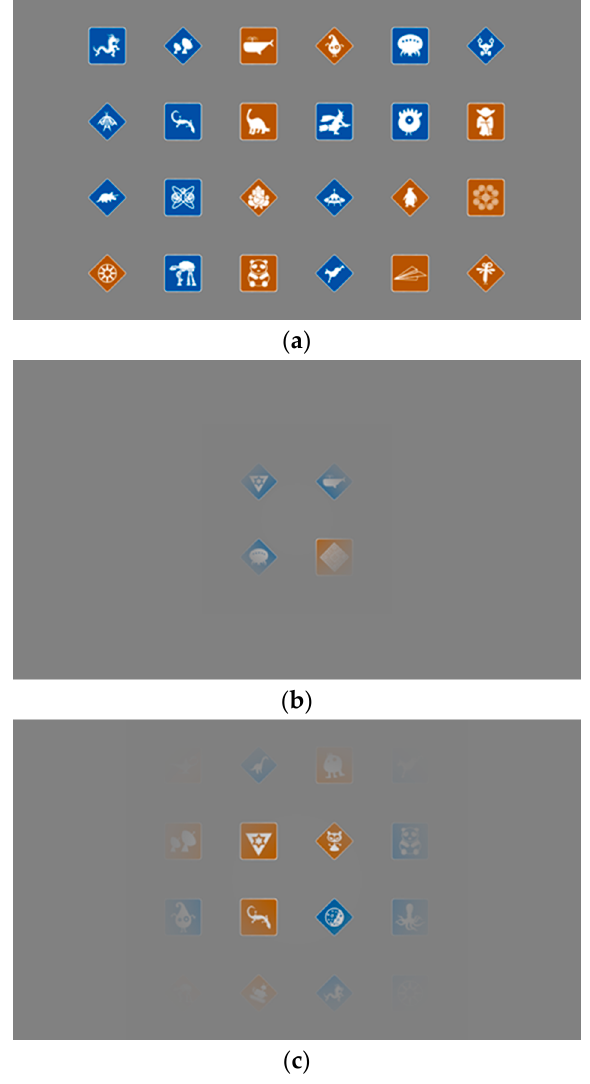
Figure 1. Sample stimuli used in the experiment. The two colors and two shapes were equally likely on every trial, but each item had a unique symbol within a trial. ( a ) Example visible area for fully visible, ( b ) example area for a 5 degree gradient aperture, and ( c ) example area for a 9 degree gradient aperture.